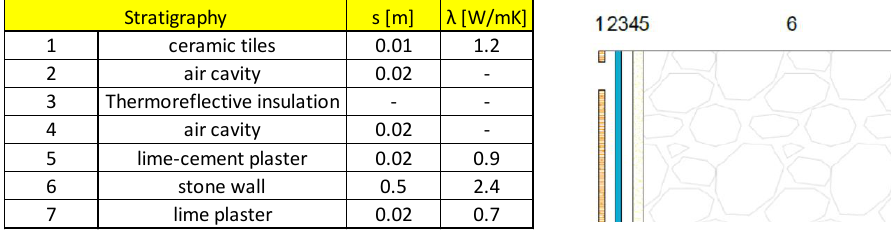
Figure A15. Wall type 5.2: stratigraphy with thicknesses and conductivities for the different layers. The numbers start from the outside. Table A8. Wall type 5.2: thermal transmittance reached with different heat-reflective materials.